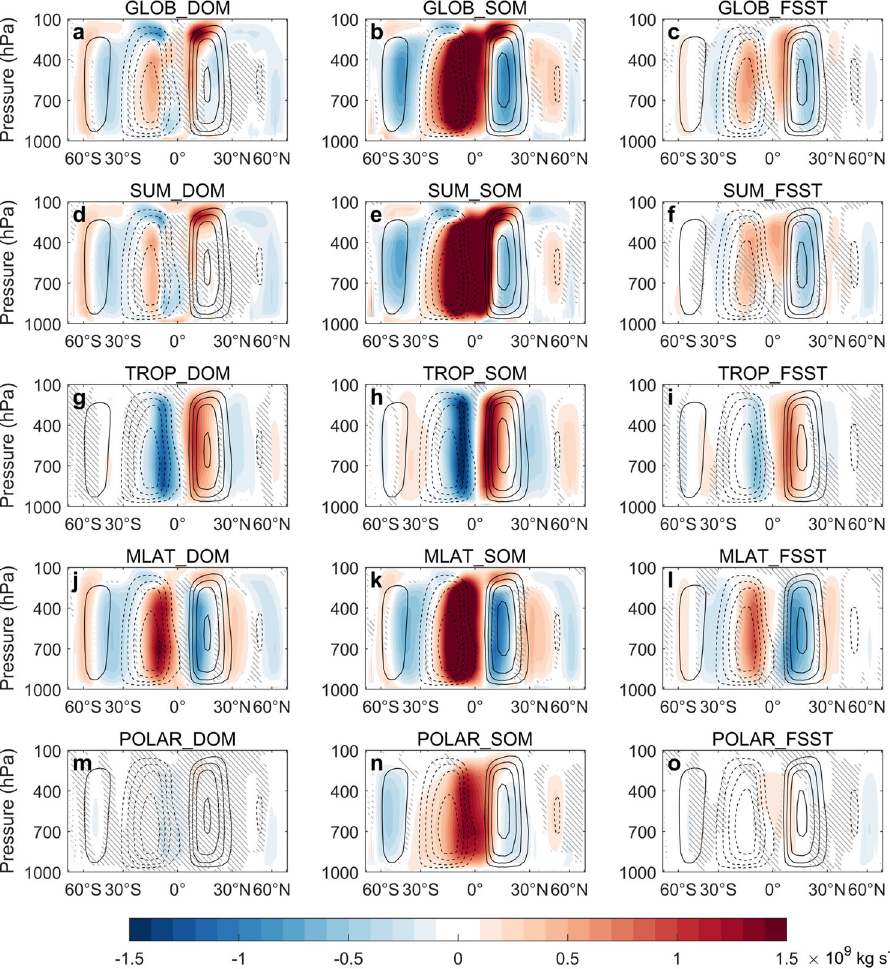
Fig. 3 Hadley circulation responses to different CO 2 forcings in the CESM experiments. The atmospheric annual-mean meridional streamfunction responses in shading (interval = 10 8 kg s − 1 ) relative to the control experiment climatologies shown in contours (interval = 2 × 10 10 kg s − 1 ) for a – c GLOB, d – f sum of all regional forcing experiments (SUM), g – i TROP, j – l MLAT, and m – o POLAR in the (1 st column) DOM, (2 nd column) SOM, and (3 rd column) FSST con fi gurations. Positive values (red shading and solid contours) correspond to a clockwise circulation and negative values (blue shading and dashed contours) to a counterclockwise circulation. Hatched regions indicate statistically insigni fi cant values at the 95% con fi dence level based on a two-tailed t ‐